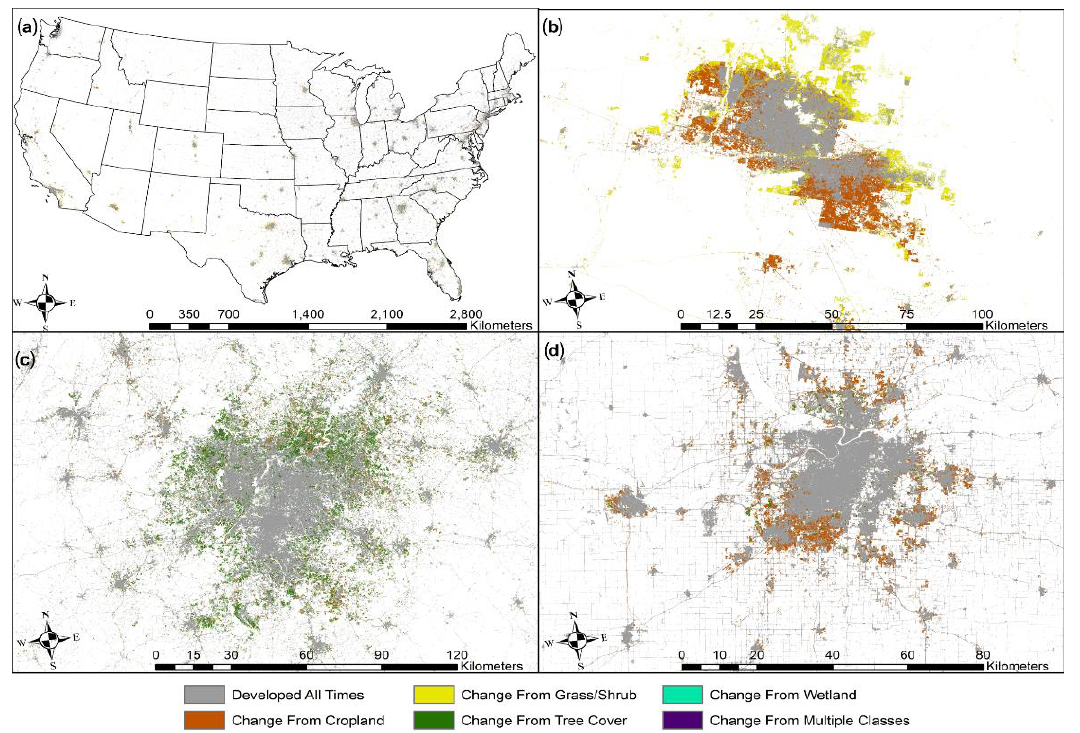
Figure 5. Examples of developed land-cover gain within a predominately stable developed land-cover base ( a ), while new development can be seen at the local scale ( b – d ). The Phoenix metropolitan area (approximate center coordinate in Decimal Degrees (DD) 33.439081 N, − 112.075208 W) is an example of a fast-growing Sunbelt urban area where one of the main sources of new developed land cover was grass/shrub, along with cropland conversion to developed ( b ). The Atlanta area (approximate center coordinate in DD 33.745106 N, − 84.387308 W) is typical of eastern U.S. urban itan (approximate center coordinate in DD 39.076467 N, −94.602064 W) area’s main source of new